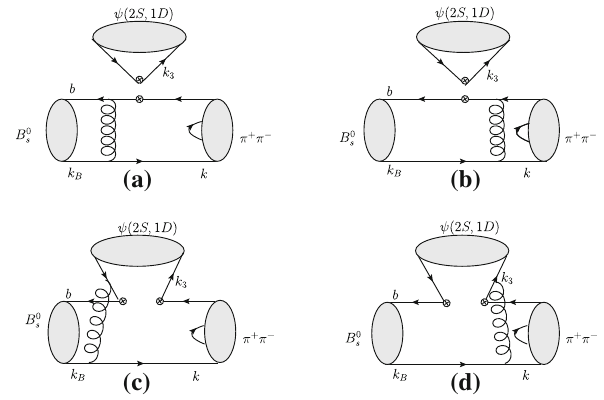
Fig. 1 The lowest order Feynman diagrams for the B 0 s → ψ f 0 ( → π + π − ) decays